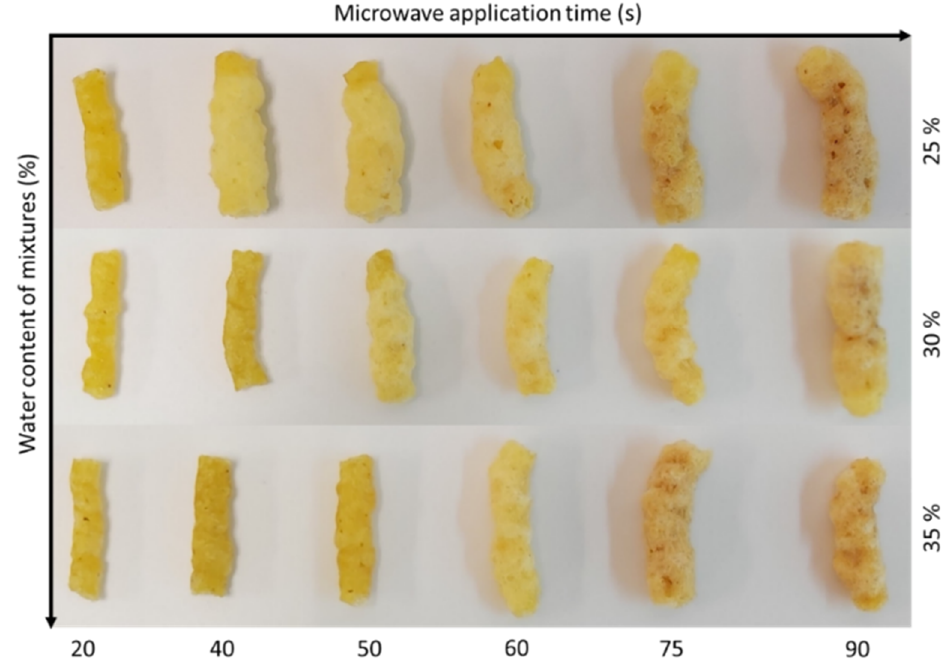
Figure 3. Evolution of appearance as a function of the processing time for three different water con- tent mixtures (25, 30, and 35%). content mixtures (25, 30, and